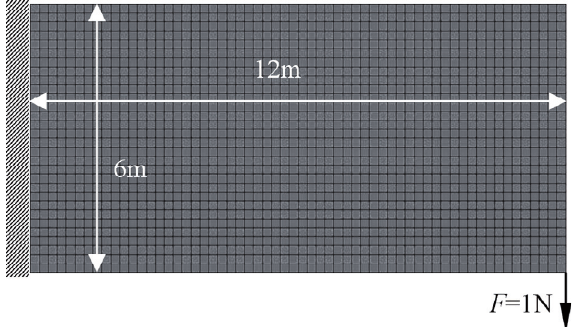
Fig. 12. Design domain and basic mesh of the plate.